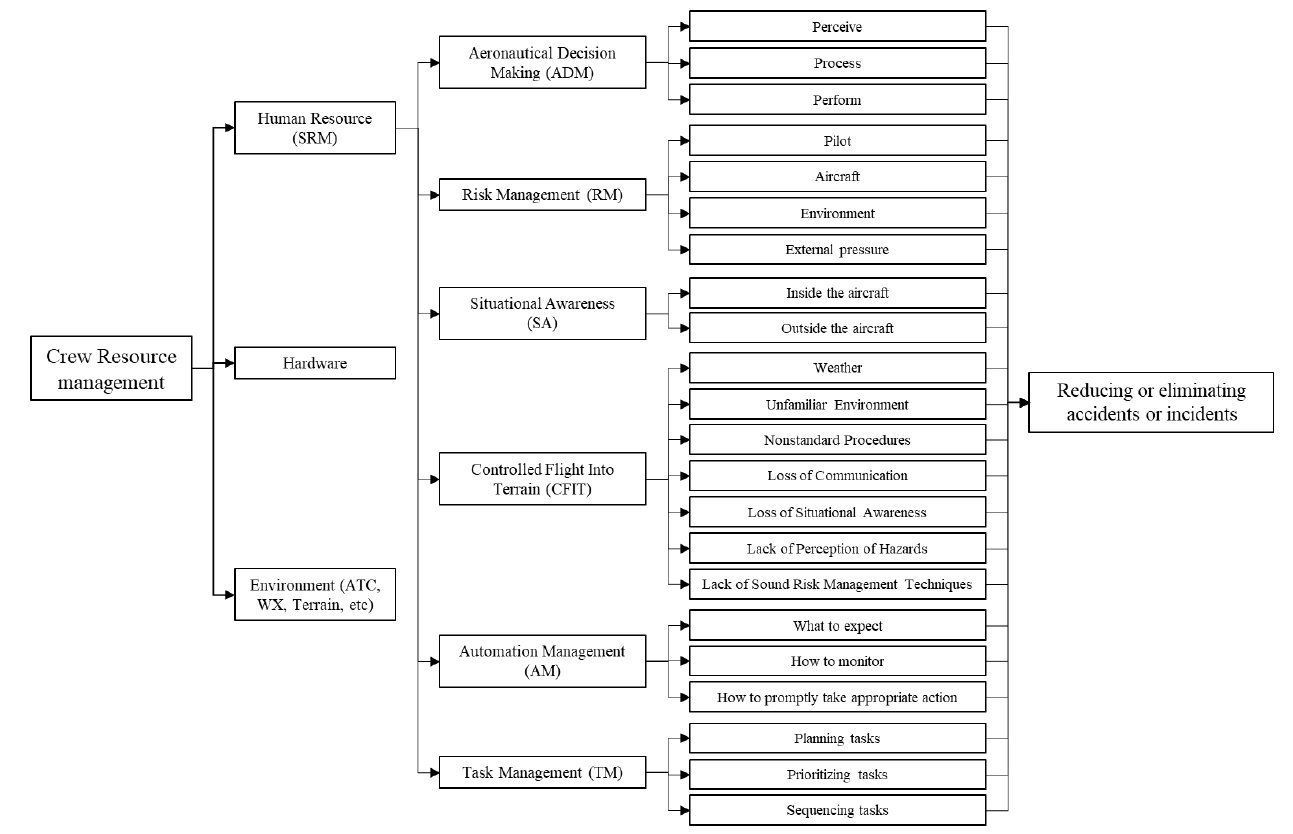
Figure 2. Research Model: CRM and SRM’s Hierarchical Structure.